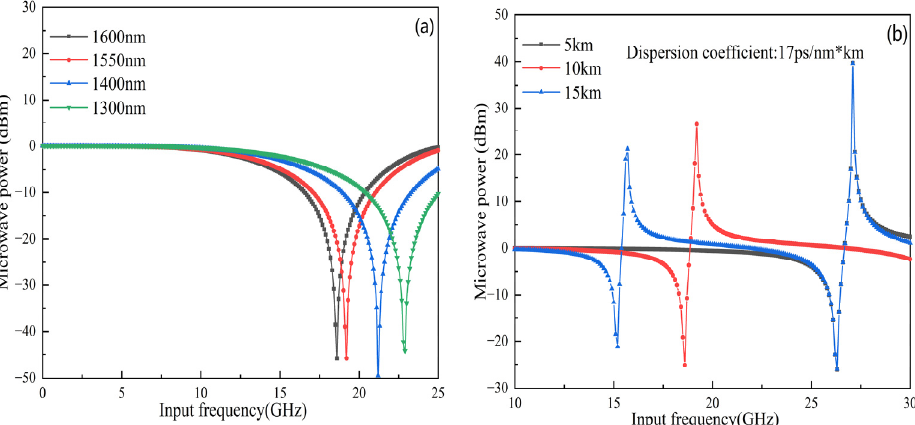
Figure 2. ( a ) The relationship between frequency and microwave power at different wavelengths. ( b ) Microwave power curves of different fiber lengths.